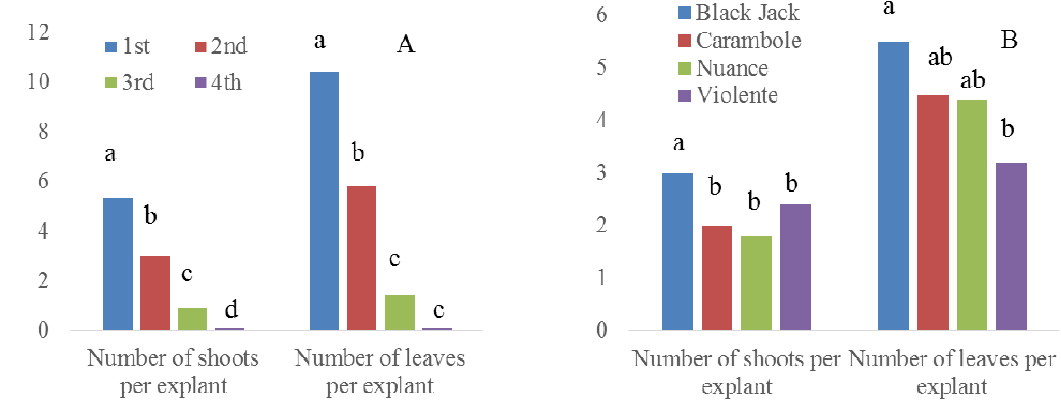
Fig. 2. Effect of slicing positions and responses of varieties on shoot initiation. A. Effect of slicing positions on shoot initiation. B. Effect of responses of varieties on shoot initiation, B. Histograms followed by the same letter in the same cluster are not significant different based on Tukey test, p = 0.05.